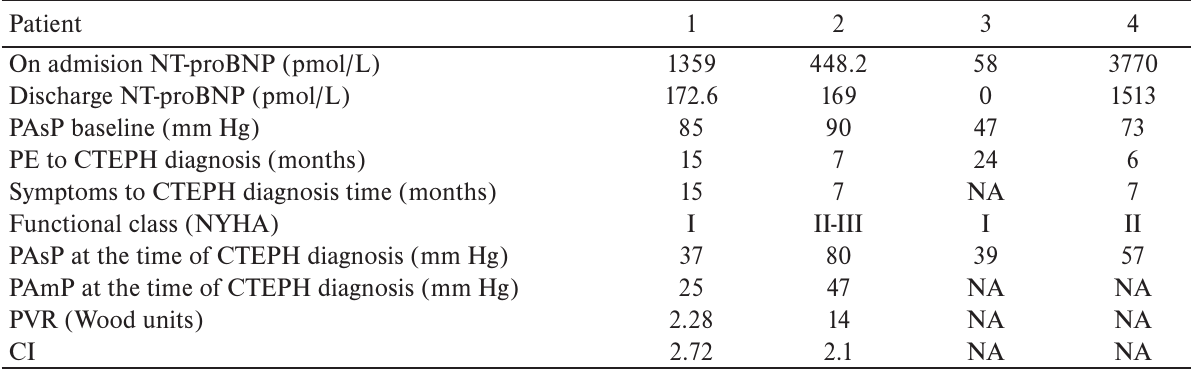
Table 3. CTEPH patient